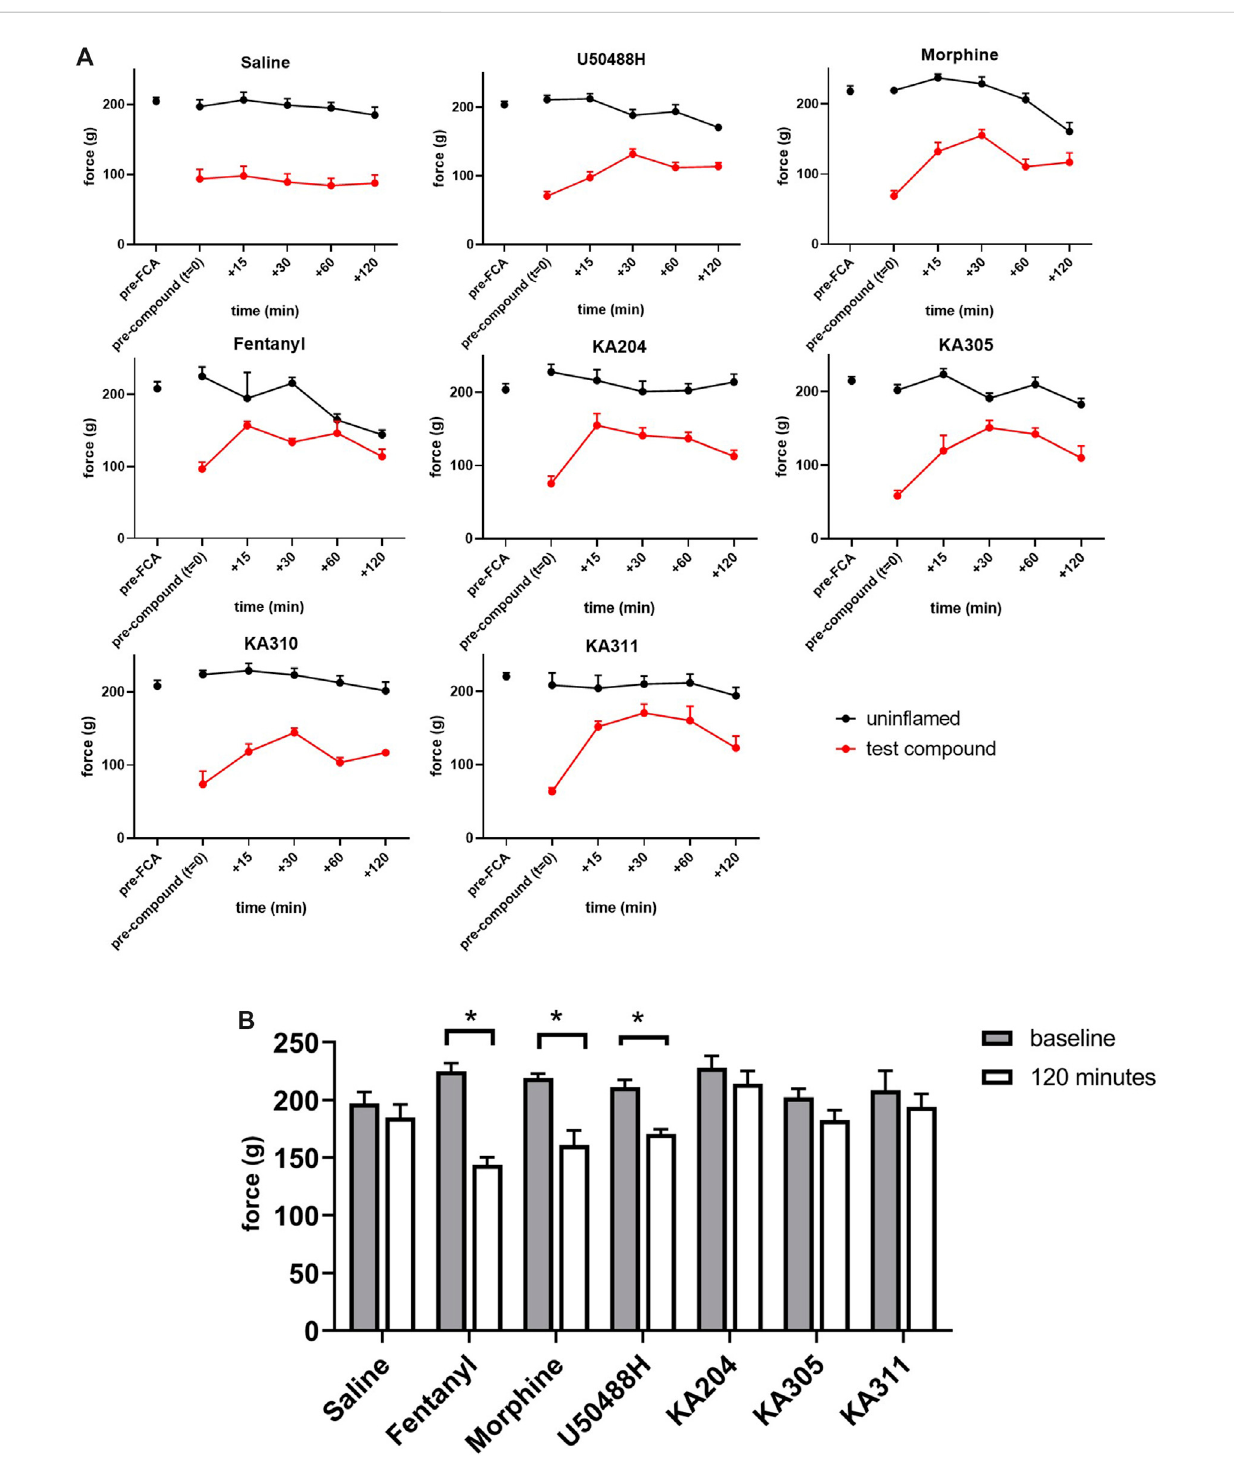
FIGURE 9 Threshold of paw withdrawal to mechanical stimulus, over time as measured by Randall-Selitto assay, in the FCA model of in fl ammatory pain. (A) Force required to elicit a paw-withdrawal response for individual compounds tested in the FCA-treated paw and un-in fl amed paw (contralateral), after compound administration (after t = 0). Data shown are means ± SEM; n = 6 per group. * p < 0.05, signi fi cant difference between t = 0 and t = 120 min in contralateral paw (B) Force required to elicit a paw withdrawal response in the contralateral/un-in fl amed paw at baseline ( t = 0, prior to compound administration) and at t = 120 min following compound administration in the ipsilateral paw. Data shown are means ± SEM; n = 6 per group. * p < 0.05, signi fi cantly different as indicated; paired t